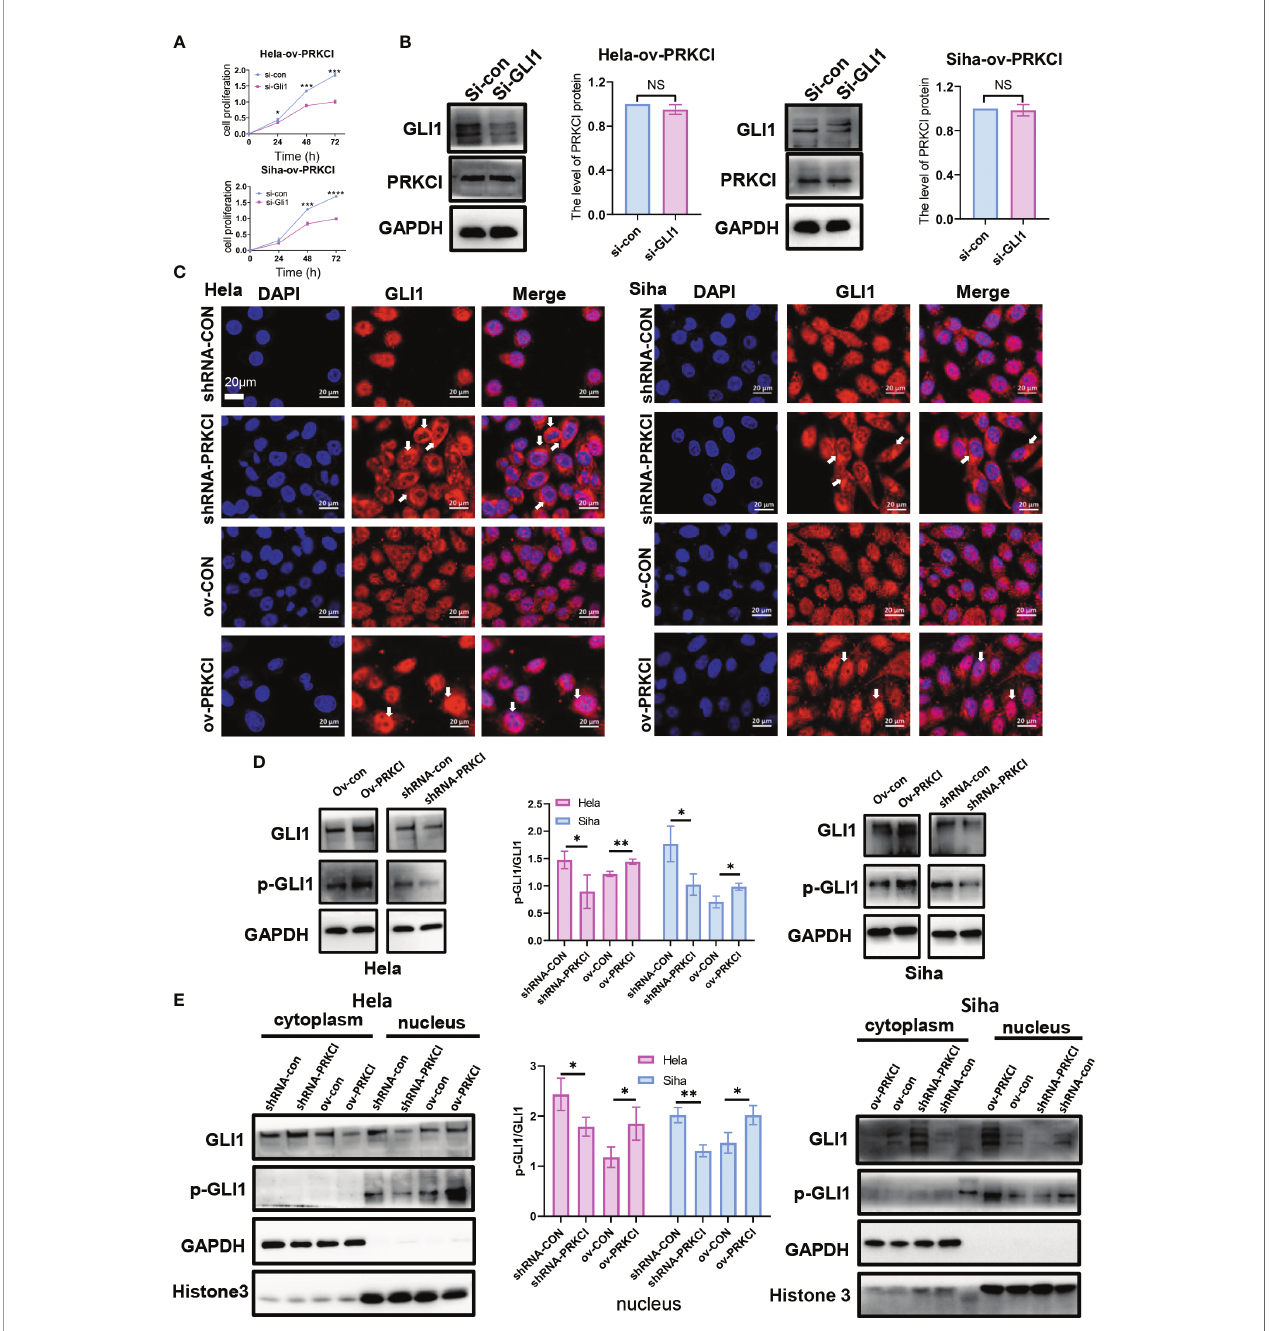
FIGURE 6 | PRKCI mediated radiosensitivity in CC via the Hh signaling pathway to change GLI1 localization. (A) The viability of the si-GLI1-transfected HeLa-ov- PRKCI and SiHa-ov-PRKCI cells after radiotherapy at 8 Gy determined by CCK-8 assays. (B) Western blotting assays were used to assess the protein expression of PRKCI when GLI1 expression was downregulated by siRNA in both the HeLa-ov-PRKCI and SiHa-ov-PRKCI cells. (C) The relative protein localization of GLI1 after transfection with shRNA-con and shRNA-PRKCI or ov-con and ov-PRKCI in the HeLa and SiHa cells treated with radiation was determined by immuno fl uorescence assays. (D) Western blotting analysis of GLI1 and p-GLI1 protein levels in the shRNA-PRKCI- and ov-PRKCI-transfected HeLa and SiHa cells. (E) Western blotting analysis of GLI1 and p-GLI1 protein levels in the cytoplasmic and nuclear fractions of the shRNA-PRKCI- and ov-PRKCI-transfected HeLa and SiHa cells. Scale bars are shown. Data are shown as the mean ± SD from three independent experiments. NS, not signi fi cant. *p < 0.05; **p < 0.01; ***p < 0.001; ****p < 0.0001 by multiple t-tests (A) . CC, cervical cancer; CCK-8, Cell Counting